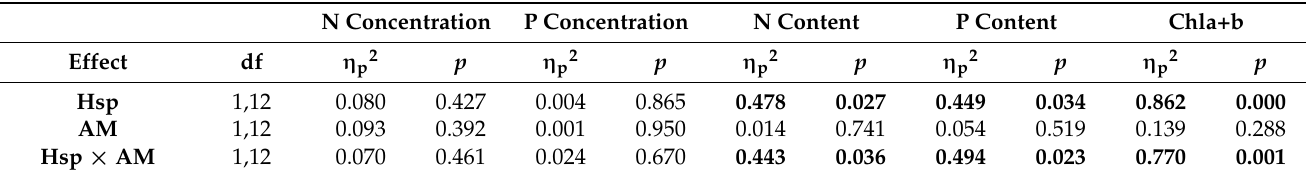
Values suggesting significant effects ( p < 0.05) are given in